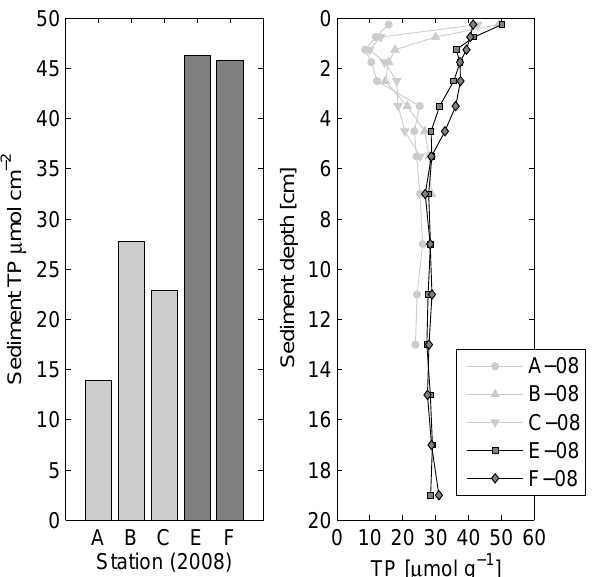
Fig. 2. Total phosphorus (TP) inventory (0–3cm) (left panel) and profiles (right panel) in sediment from five stations in the Eastern Gotland Basin 2008. Stations with oxic bottom water are shown in a lighter grey colour and those with anoxic bottom water in a darker grey colour.